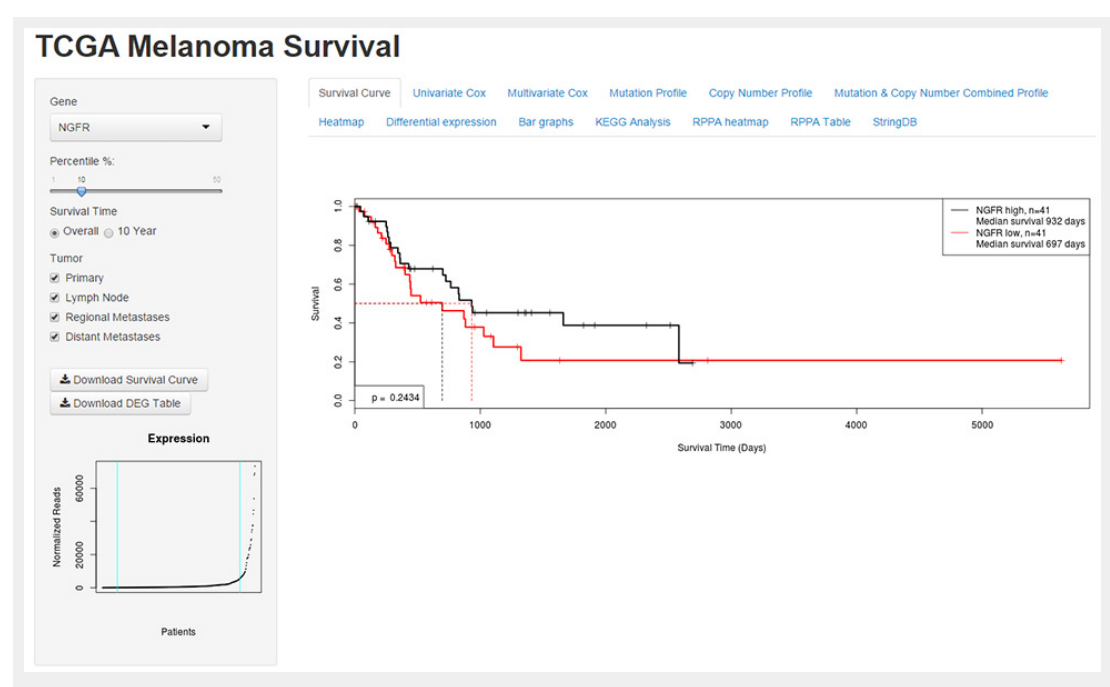
Snapshot of UZH Cancer Browser. Left panel shows selectable parameters for gene, patient percentile, survival time and tumor type. Normalised expression of NGFR accross all patients can be seen in the scatterplot in the bootom left corner. In the main panel of the webtool, tabs for the analysis modules can be selected for visualisation. In this snapshot the survival curve module is selected and the Kaplan-Meier plot is